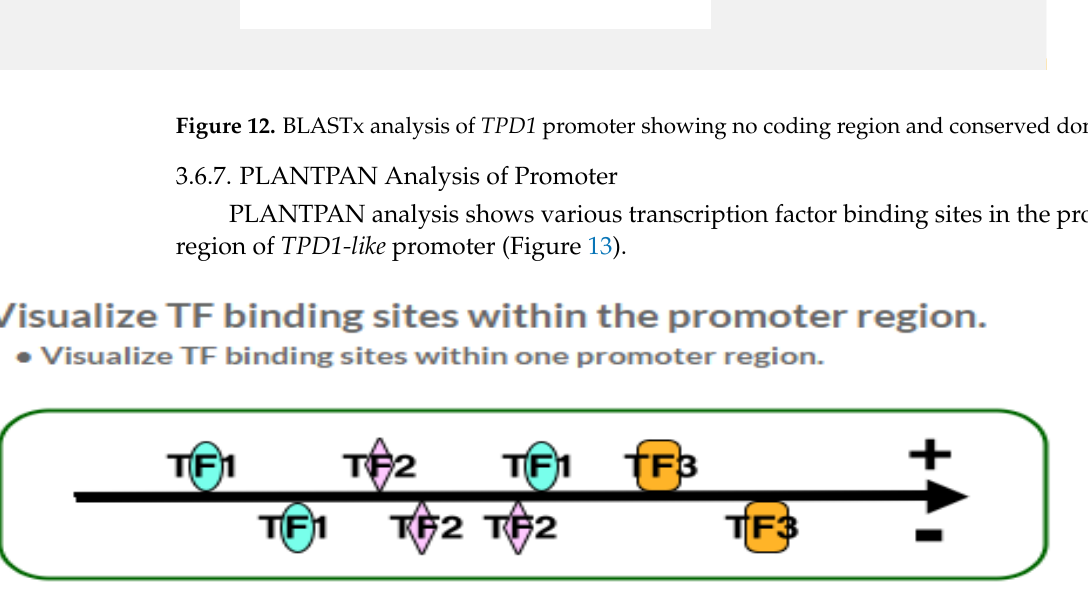
Figure 13. Transcriptional factor binding sites in TPD1 -promoter region.